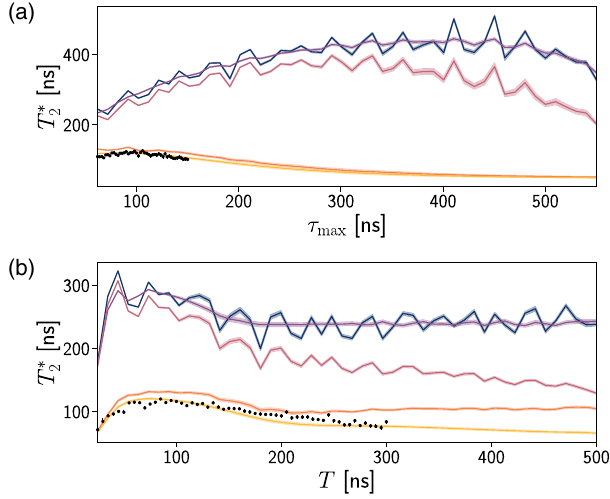
FIG. 13. Effects of relaxation and dephasing on feedback performance. (a),(b) T (cid:4) 2 versus maximum sensing time τ and actuation time T , respectively. Black circles are the measured values (also shown in the main text, Fig. 3) with error bars representing the 68% confidence intervals. The solid curves are simulations of the data using the model parameters found in Appendix E 6, but where we include only one amplitude or phase-damping channel at a time. The blue curve is an entirely unitary quantum evolution, except for the explicit dissipative reset step. For the purple curve we include pure nuclear dephasing during actuation (Appendix E 3 d). For the pink curve we instead include optically induced electron relaxation (Appendix E 3 c).